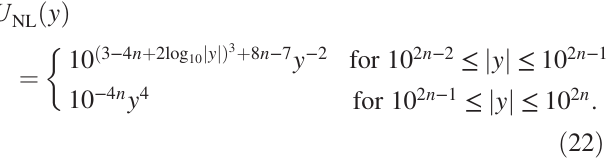
FIG. 6. Pathological potential U together with the global trend y 2 = 10 (red). For j y j ∈ ½ 10 2 n − 1 ; 10 2 n (cid:2) with n ∈ Z , U NL ð y Þ grows faster than a second- order polynomial, in particular, U black lines). However, in the limit y → ∞ , the ratio U y Þ =y 2 remains NL ð